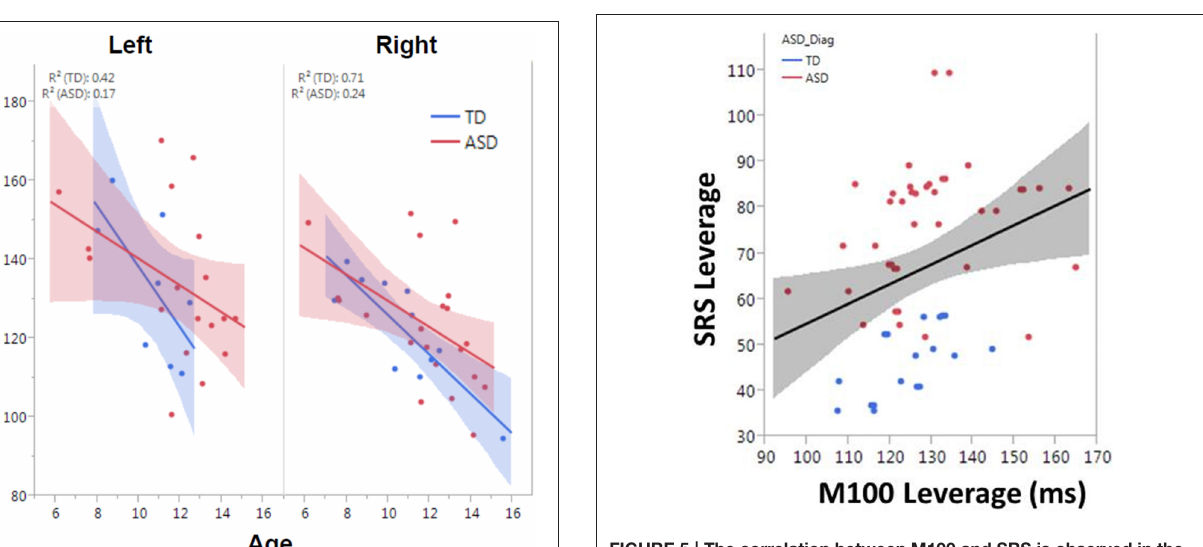
Frontiers in Neuroanatomy |